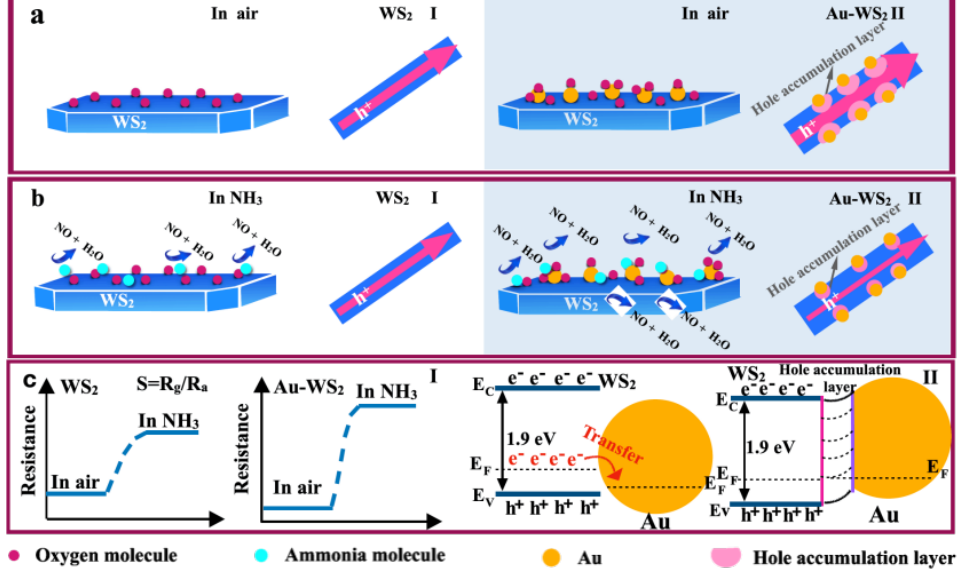
Figure 7. Schematic diagram of the pure WS 2 and Au/WS 2 sensors exposed to air and ammonia gas. ( a ) pure WS 2 sensors in air and ammonia gas ( b ) Au/WS 2 sensors in air and ammonia gas ( c )